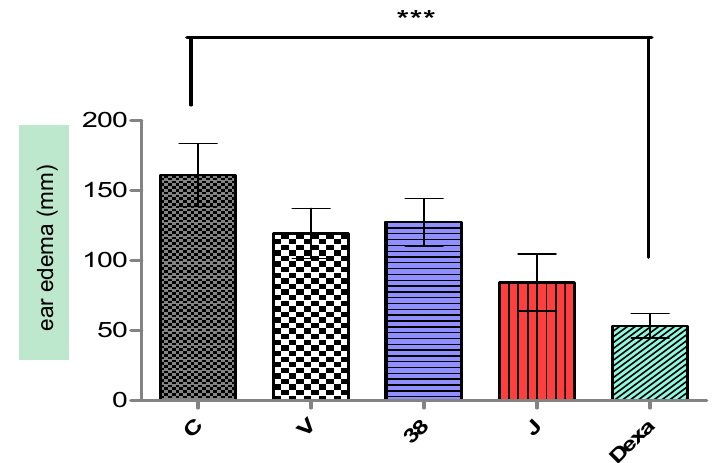
Figure 4. Ear edema induced by croton oil in untreated and treated animal groups. ( C ) Negative Figure 4 . Ear edema induced by croton oil in untreated and treated animal groups. control; ( V ) vehicle; ( F-38 ) nanoemulsion without extracts; ( F-38J ) nanoemulsion with extracts; ( C ) Negative control ; ( V ) vehicle; ( F-38 ) nanoemulsion without extracts; ( F-38 J ) nanoemulsion ( Dexa ) dexamethasone solution. Values represent the mean and the respective standard deviations with extracts; ( Dexa ) dexamethasone solution. Values represent the mean and the respective ( n = 6–8). *** Significance level compared to the control group ( C ) ( p < standard deviations ( n = 6–8) . *** Significance level compared to the control group ( C ) ( p < 0.001).